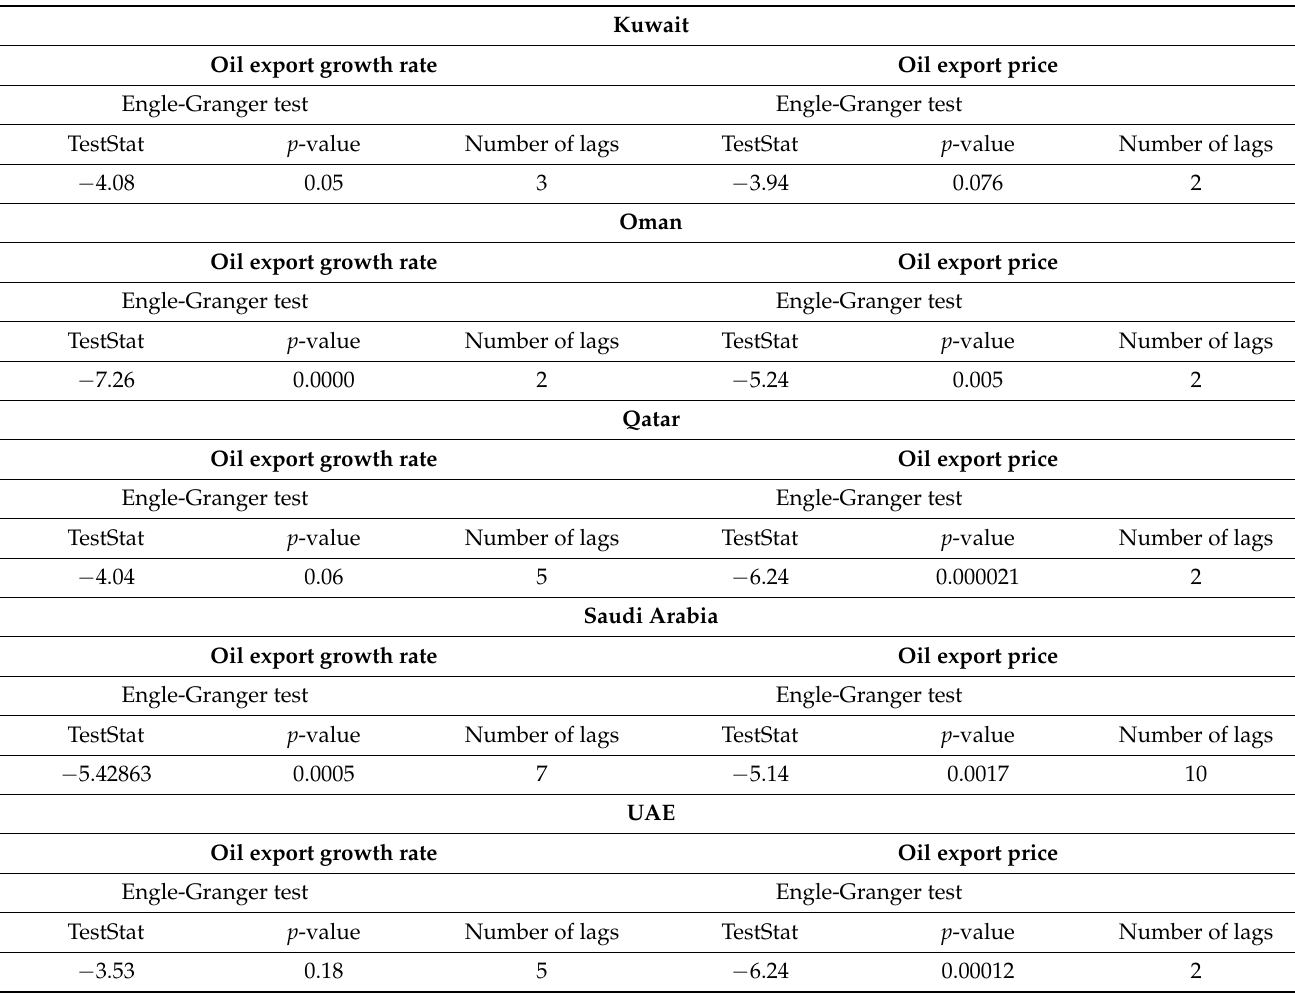
Table 3. Cointegration